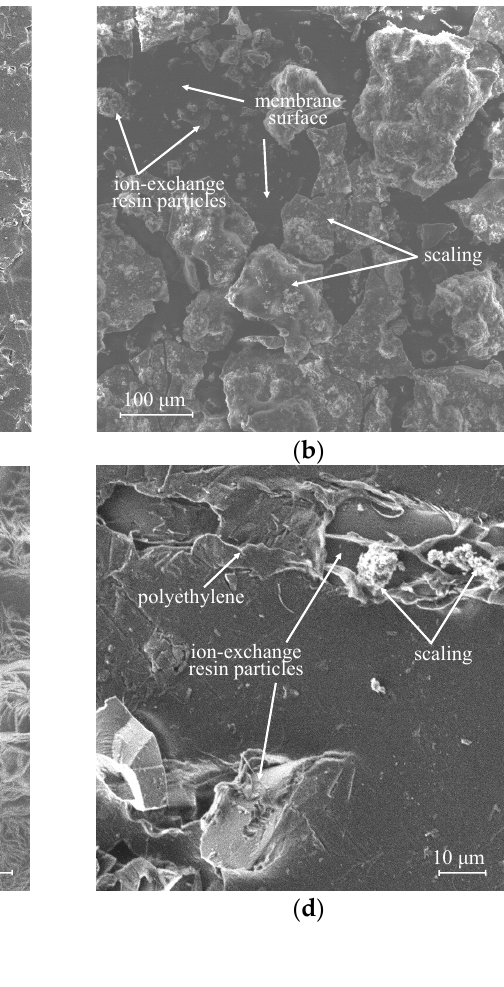
Figure 9. Photographs of the surfaces of MA-41P ( a ), MA-41Pmod ( b ), Ralex AMH-PES ( c ), and Ralex AMH-PESmod ( d ) anion-exchange membranes, facing the concentration chamber, after their operation in the artificial solution.